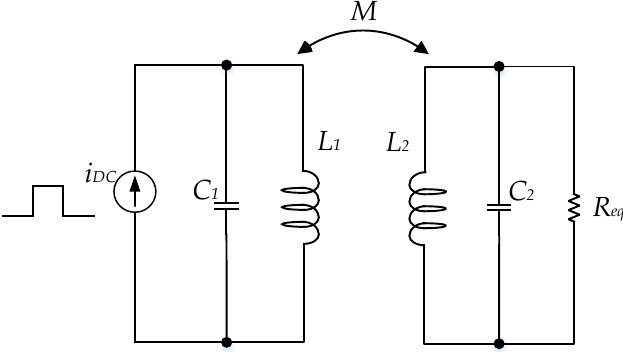
Figure 2. Equivalent circuit of current-fed push-pull parallel-resonant circuit.